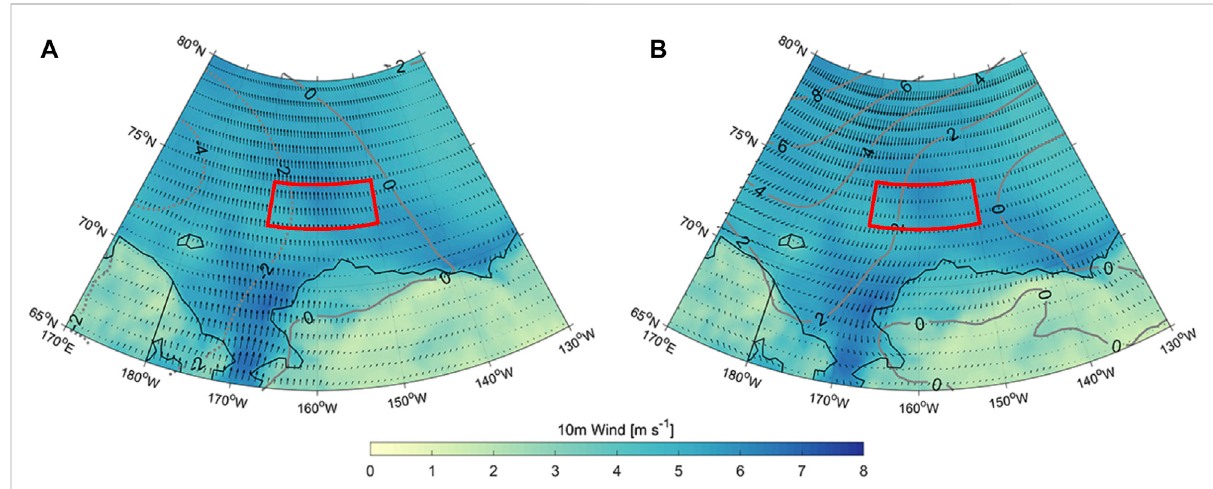
FIGURE 7 The MSLP anomaly fi eld (contour, the solid gray line is the positive anomaly, the gray dashed line is the negative anomaly) in July 2019 (A) and July 2020 (B) superimposed on the 10 m wind fi eld. The coloring shows the value of the wind fi eld and the arrows indicate the direction. Red polygons encapsulate areas represents the study area of this